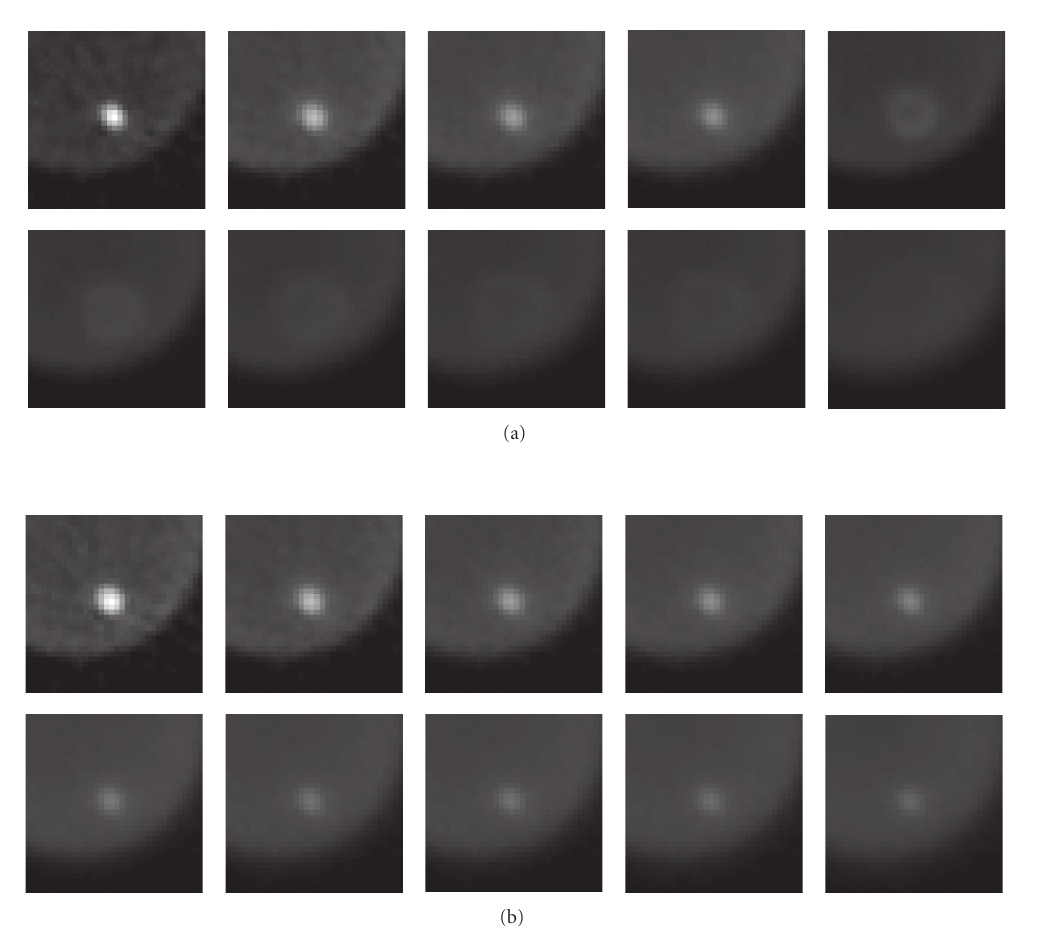
Figure 9: The hotspot data filtered with the di ff erent nonlinear L-filters for the compared methods. In (a), cropped FBP images for radial sinogram filtering, and the corresponding images for angular stackgram filtering in (b). The filter weights increase from left to right at each row in both figures. In (a), notice that after the second image (top row), the peak has a totally di ff erent shape compared to the initial shape. In (b), the width of the peak in the images remains almost invariable regardless of the filter